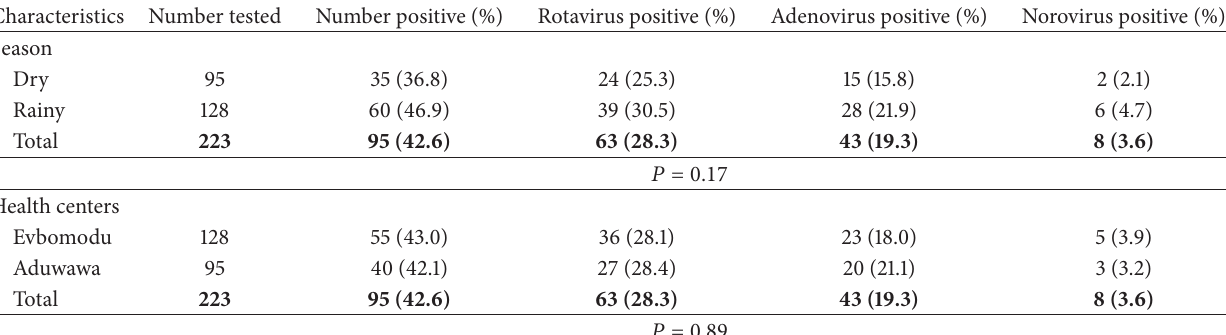
Table 4: Seasonal pattern of enteric viruses and distribution according to health centers.